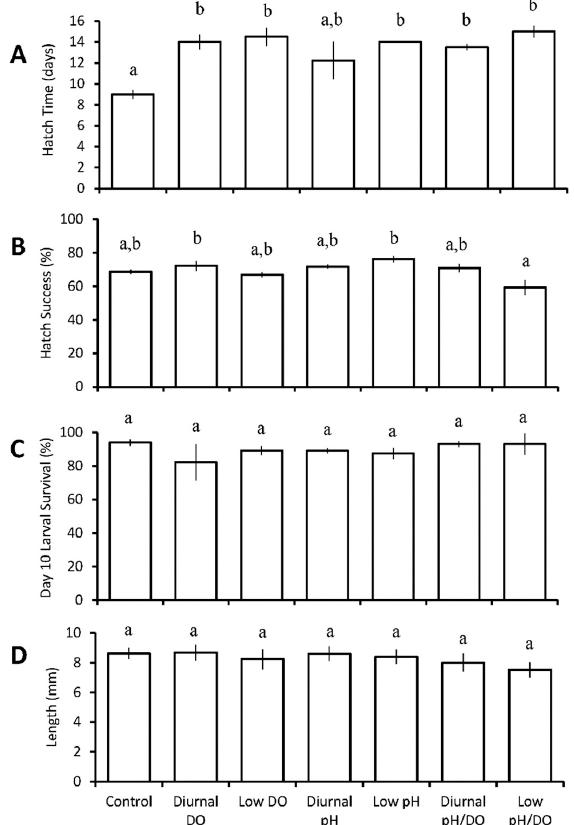
Figure 2. Hatch time ( A ), hatch success ( B ), survival ( C ), and length ( D ) of Cyprinodon variegatus larvae in the seven treatment diurnal acidification and hypoxia experiments (Table 3 and Tables S5–S8). Bars represent the mean (n = 4) for each treatment. Error bars represent standard error of the mean (n = 4). Letters on bars represent significant di ff erences among groups as determined by Tukey Honest Significance Di ff erence